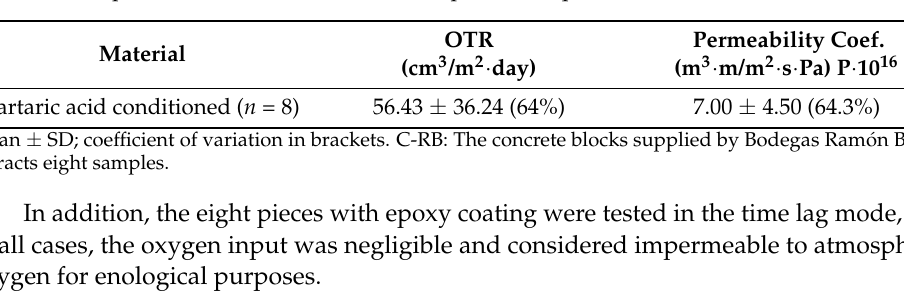
Table 9. Main permeation results of tested C-RB pieces in liquid contact mode.